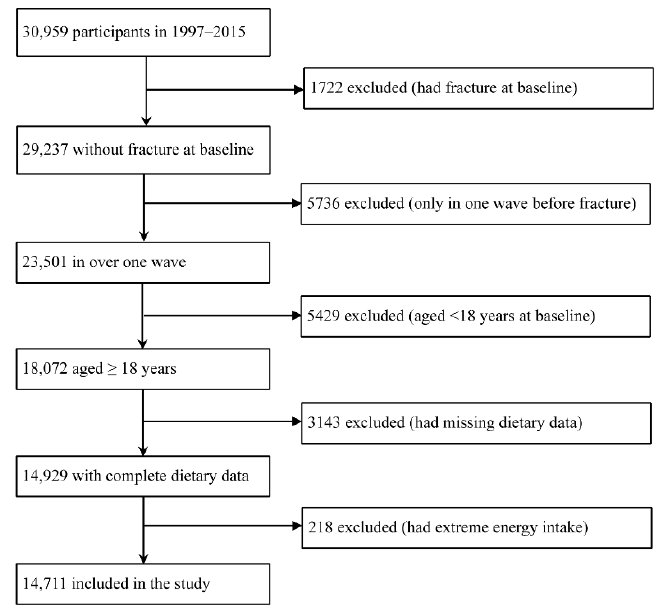
Figure 1. Flow chart of included participants.